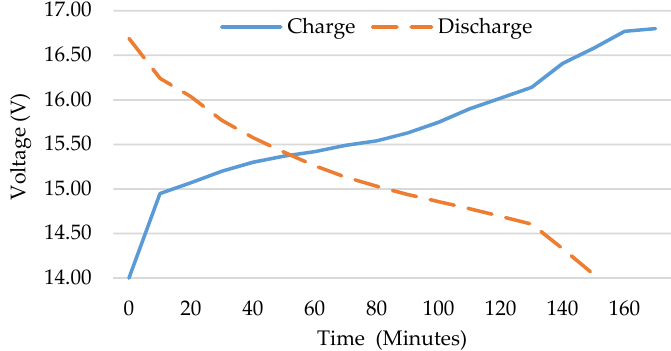
Figure 6. The experimental validation of the battery showing the charging and discharging curves under a 2-A current source and load, respectively.